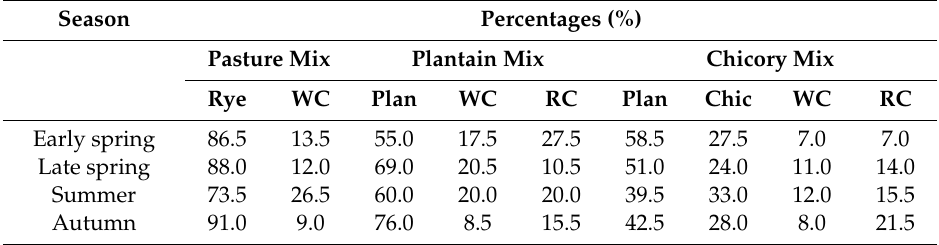
Table 1. Percentages of tagged plant species in the herbage treatments (pasture mix, plantain mix and chicory mix) at the start of each grazing season. Ryegrass (Rye), white clover (WC), plantain (Plan), red clover (RC), chicory (Chic).